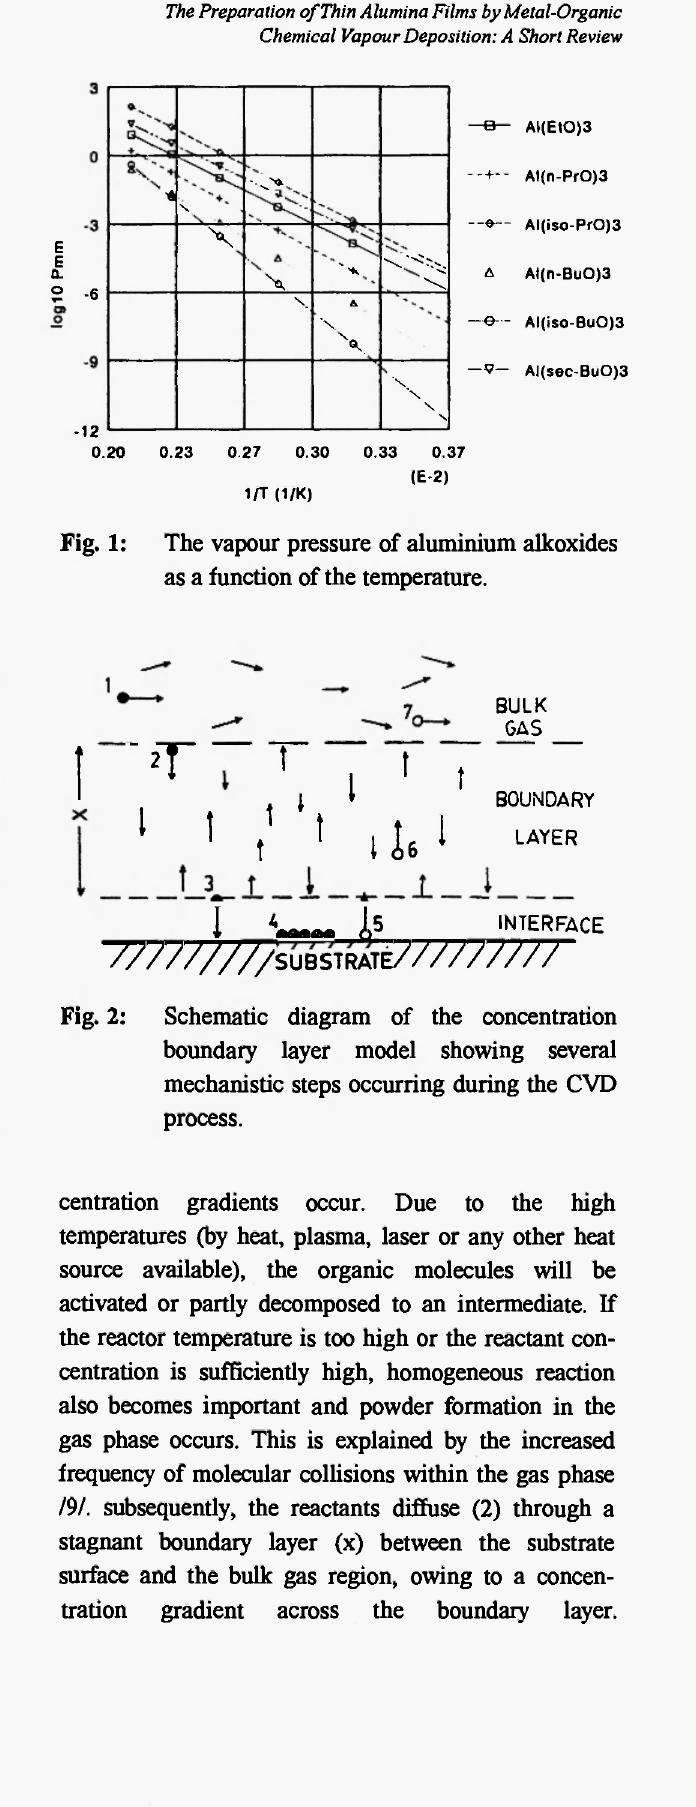
Fig. 2: Schematic diagram of the concentration boundary layer model showing several mechanistic steps occurring during the CVD process. centration gradients occur. Due to the high temperatures (by heat, plasma, laser or any other heat source available), the organic molecules will be activated or partly decomposed to an intermediate. If the reactor temperature is too high or the reactant con- centration is sufficiently high, homogeneous reaction also becomes important and powder formation in the gas phase occurs. This is explained by the increased frequency of molecular collisions within the gas phase 191. subsequently, the reactants diffuse (2) through a stagnant boundary layer (x) between the substrate surface and the bulk gas region, owing to a concen- tration gradient across the boundary